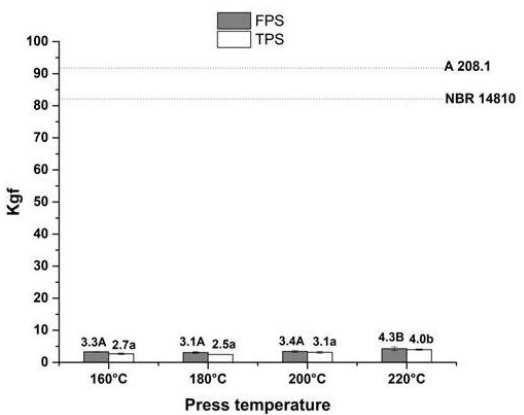
Figure 9. Face screw (FSP) and top (TSP) pull-out for particleboard panels produced with sugarcane bagasse and plastic bag particles at different pressing temperatures. * Averages followed by a similar letter (uppercase for APF lower case for APT) did not differ statistically by the Scott-Knott test at 5% significance